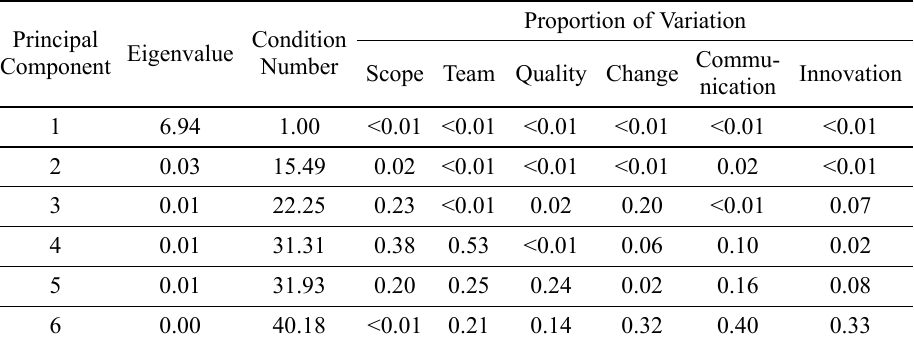
Table 5. Multicollinearity diagnostics of project-outcome prediction model (Model 6) Principal